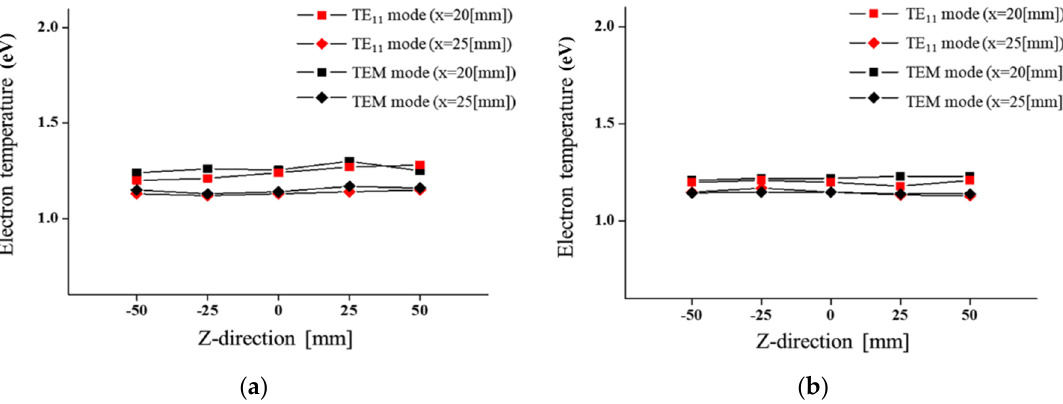
Figure 15. ( a ) Electron temperature at the substrate (Experiment) and ( b ) electron temperature at the substrate (Simulation).